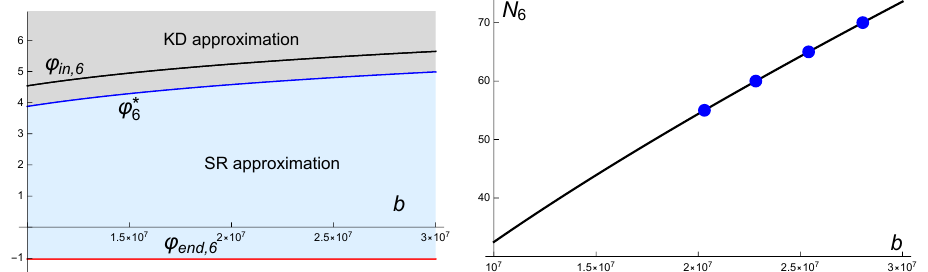
( b ) (blue line), and 6 √ √ 3 2 , µ = , c 1 = 2 × 10 − 10 , 3 4